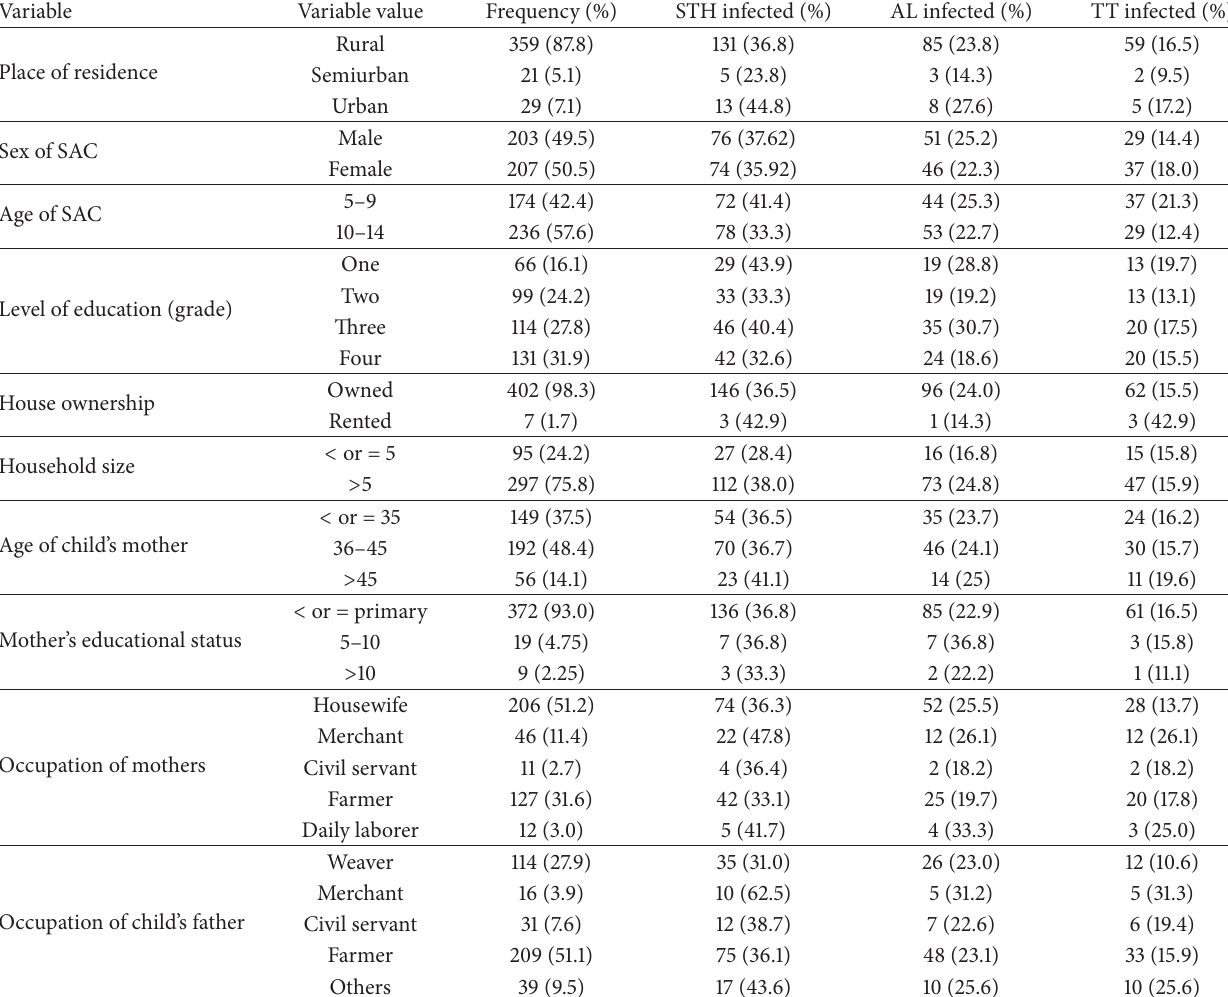
Table 1: Sociodemographic characteristics of school-age children and STH infection among SAC Chencha district, southern Ethiopia.